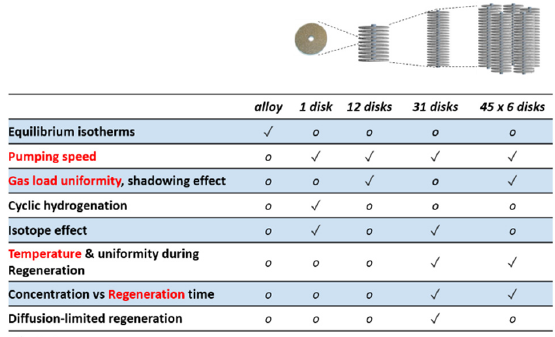
Figure 1. Matrix of the main aspects of interest, experimentally investigated on different scales of pump sizes. Each disk has a 25 mm diameter, 2 mm thickness and contains 3.5 g of ZAO ®